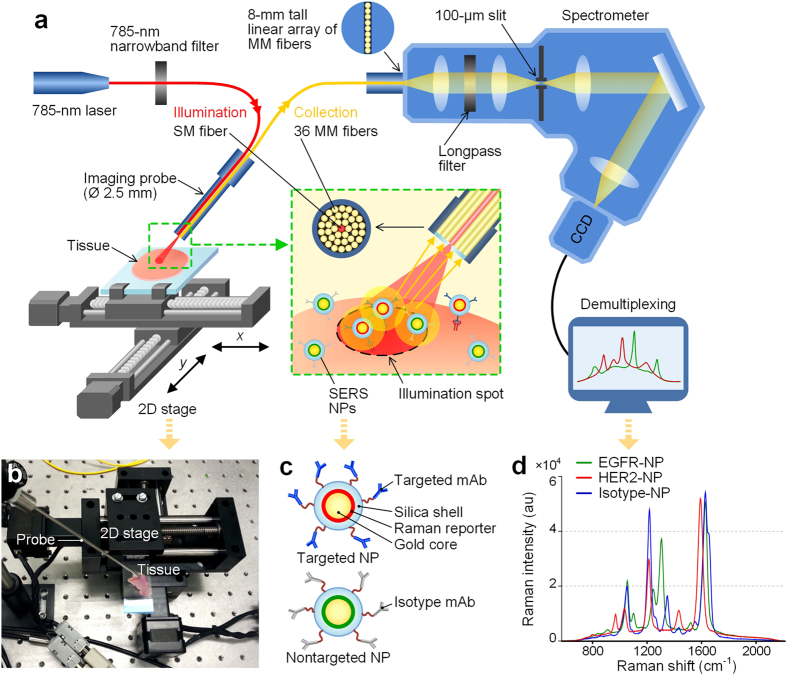
Raman imaging system.(a) Schematic of the spectral-imaging system. A 785-nm laser is used to illuminate the NP-stained tissue, creating a submillimeter-diameter laser spot. Raman-scattered photons from illuminated NPs are collected by 36 multimode fibers and transmitted to a customized spectrometer (Andor Holospec), where they are dispersed onto a cooled deep-depletion spectroscopic CCD (Andor). For raster-scanning imaging, a two-axis stage is controlled through a custom LabVIEW program to translate the tissue sample. (b) A photograph of the raster-scanned tissue-imaging device. (c) A depiction of the structure of the targeted and nontargeted SERS NPs and (d) the Raman spectra of the various SERS NPs (targeted and nontargeted) used in this study. Y.W. drew the figure.